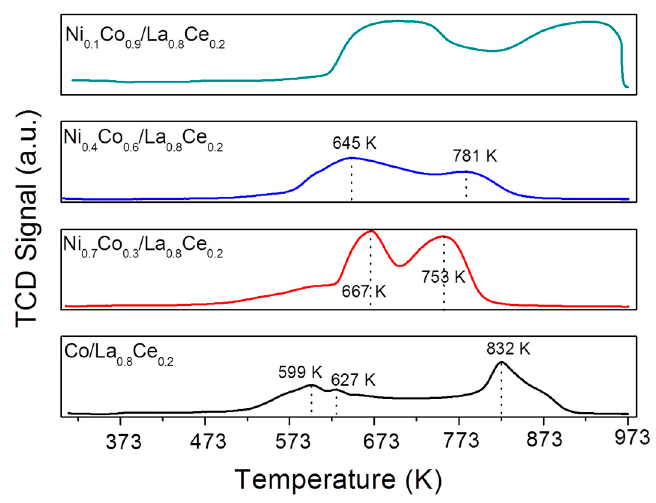
Figure 3. Temperature-programmed reduction (TPR) profiles of the prepared catalysts.